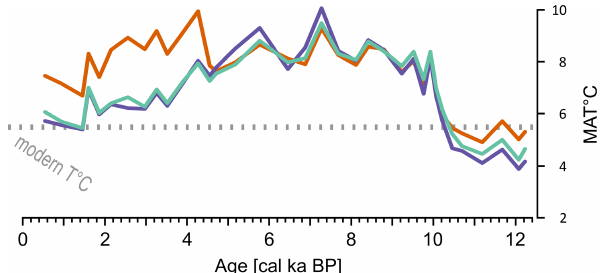
Figure 7. Reconstructed temperatures of the Garba Guracha sedi- mentary record. MBT (cid:48) (orange); Ia /( Ia + IIa + IIIa + IIIa (cid:48) ) (pur- 5ME + IIIa (cid:48) (turquoise). ple); MBT (cid:48) 5ME